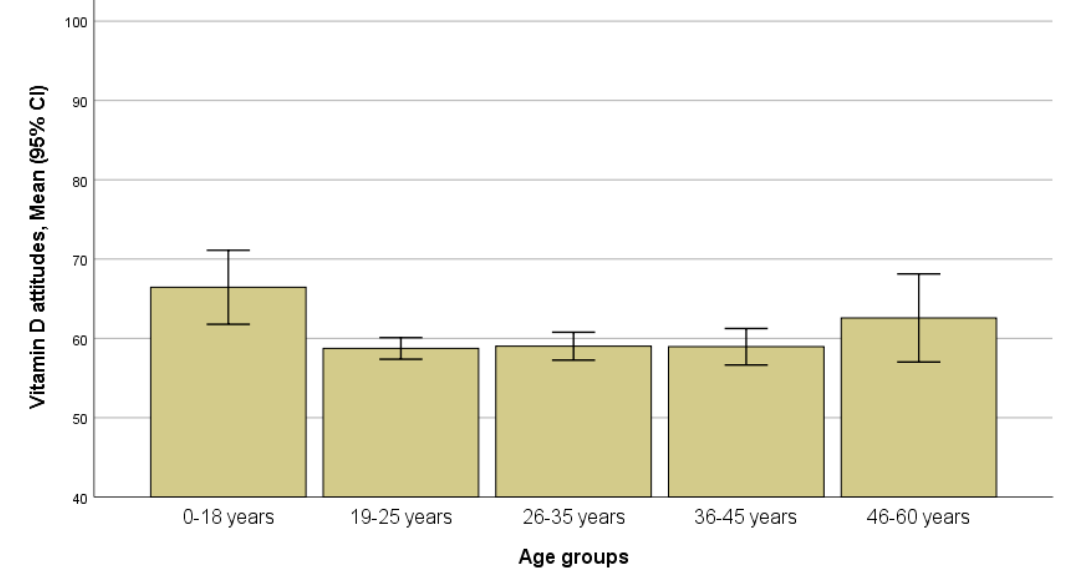
Figure 1. Scores for vitamin D attitudes in age groups ( p = 0.019, ANOVA). Figure 1 . Scores for vitamin D attitudes in age groups (p = 0.019, ANOVA). Figure 1 . Scores for vitamin D attitudes in age groups (p = 0.019, ANOVA).